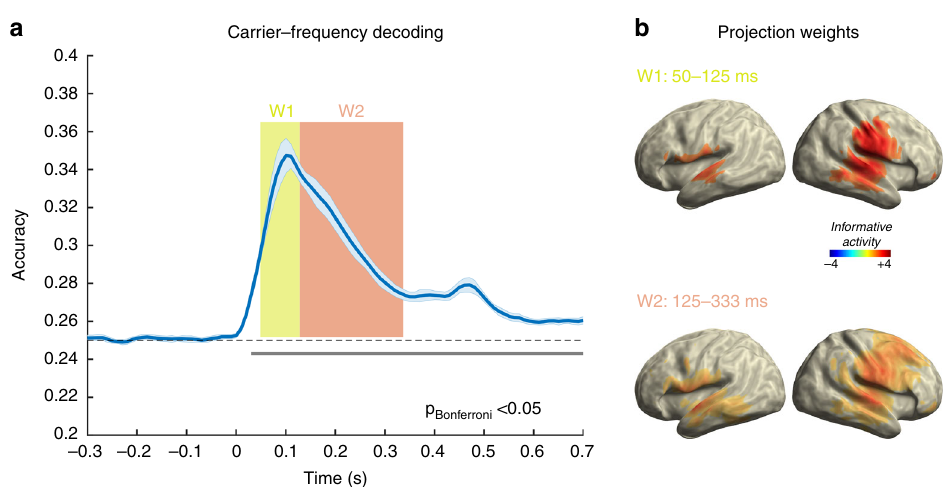
Fig. 2 Decoding carrier frequencies from random sound sequences. a Robust increase of decoding accuracy is obtained rapidly, peaking ~100 ms after which it slowly wanes. Note however that signi fi cant decoding accuracy is observed even after 700 ms, i.e. likely representing a memory trace that is (re-) activated even when new tones (with other carrier frequencies) are processed. b Source projection of classi fi er weights (relative change baseline (-100-0) ms, 50% threshold) for an early (W1) and late (W2) reveals informative activity to mainly originate from auditory cortices, with a right hemispheric dominance. During the later (W2) period informative activity spreads to also encompass e.g. frontal